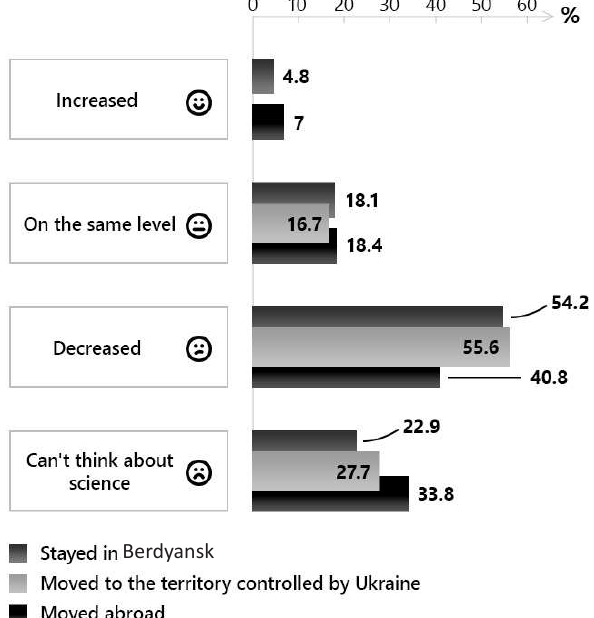
Figure 7. Subjective perception of scientific efficiency of lecturers depending on the place of